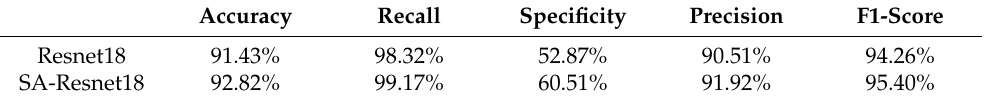
Table 4. Comparison of network indicators without attention module and with attention module.